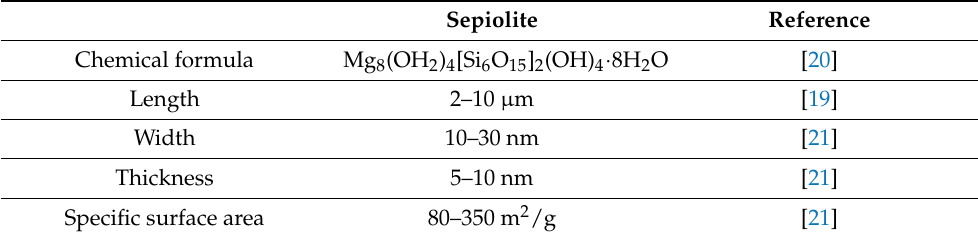
Table 1. Main physical characteristics of